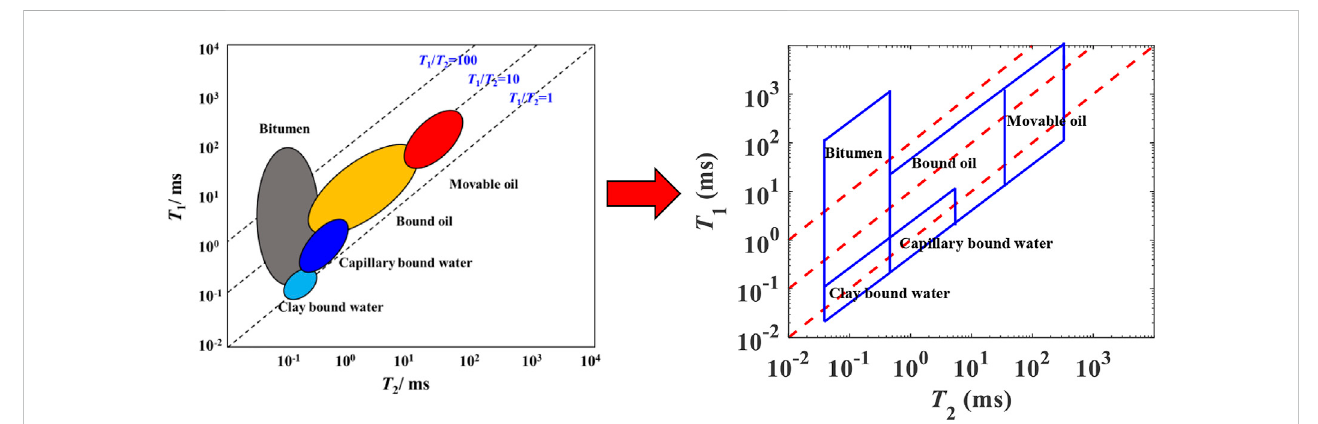
FIGURE 13 T 1 -T 2 2D NMR fl uid identi fi cation map at 2MHz for Fengcheng Formation.